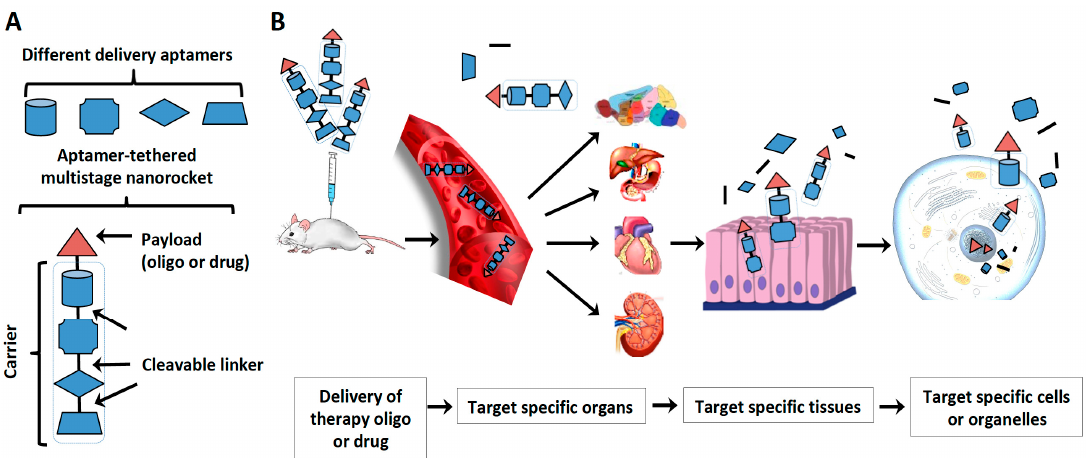
Figure 4. Aptamer-tethered multistage “nanorocket” for target-specific delivery. ( A ) An aptamer-tethered multistage “nanorocket” is a complex of two or more aptamers, each of which contains its own functional oligonucleotide. Serial stages of aptamers are mounted on top of another to build a carrier “nanorocket” for the target specific recognition and delivery. With appropriate linkages, each stage of aptamer “nanorocket” can freely rotate and perform its function. ( B ) The selected aptamers can be used in different stages of “nanorockets”, designed for tissue penetration, cell target recognition and cellular internalization. After reaching target, the recognition and delivering stages of the “nanorockets” can be cleaved and degraded by the cell leaving only the cargo oligos. Aptamers in multi-stage “nanorockets” can be used as tissue-, cell-type-, and cellular